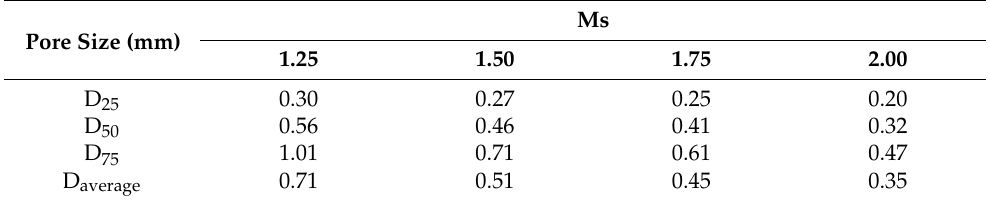
Figure 3. Microscope images and pore size distribution of porous materials under different Ms. Table 5. Pore size statistics under different activator moduli (paste = 150 g, Na 2 O% = 4%, W/B = 0.5, Al powder = 0.2%, LS replacement =